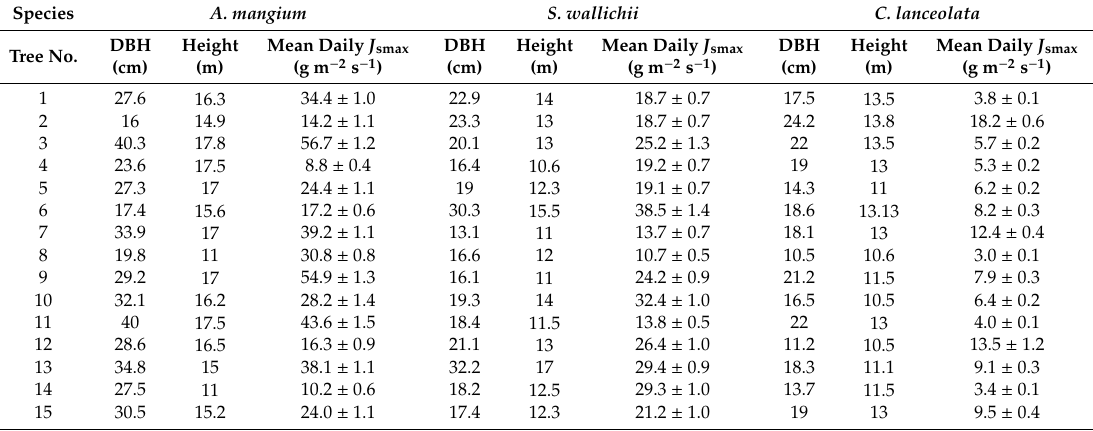
Table 3. DBH, tree height and mean daily maximum sap flux density ( J smax ± standard error) of the three